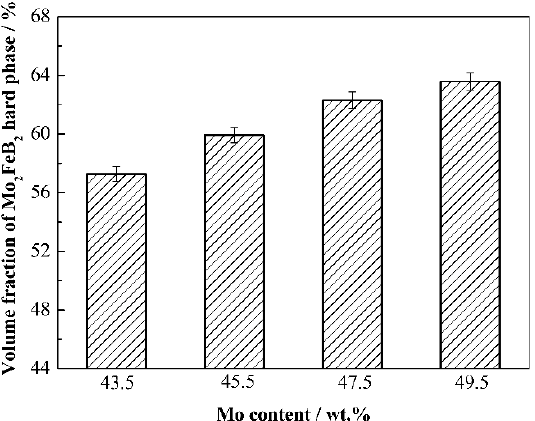
Figure 5. Volume fraction of Mo 2 FeB 2 hard phase with different Mo contents.